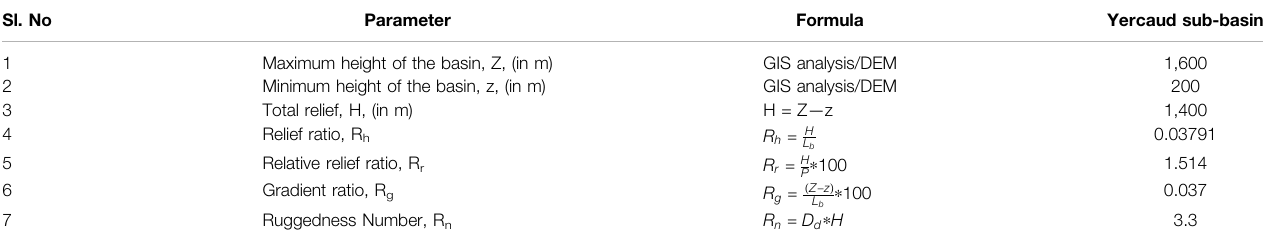
TABLE 8 | Relief parameters of the Yercaud sub-basin, Dharmapuri district, Tamil Nadu, India. Sl.